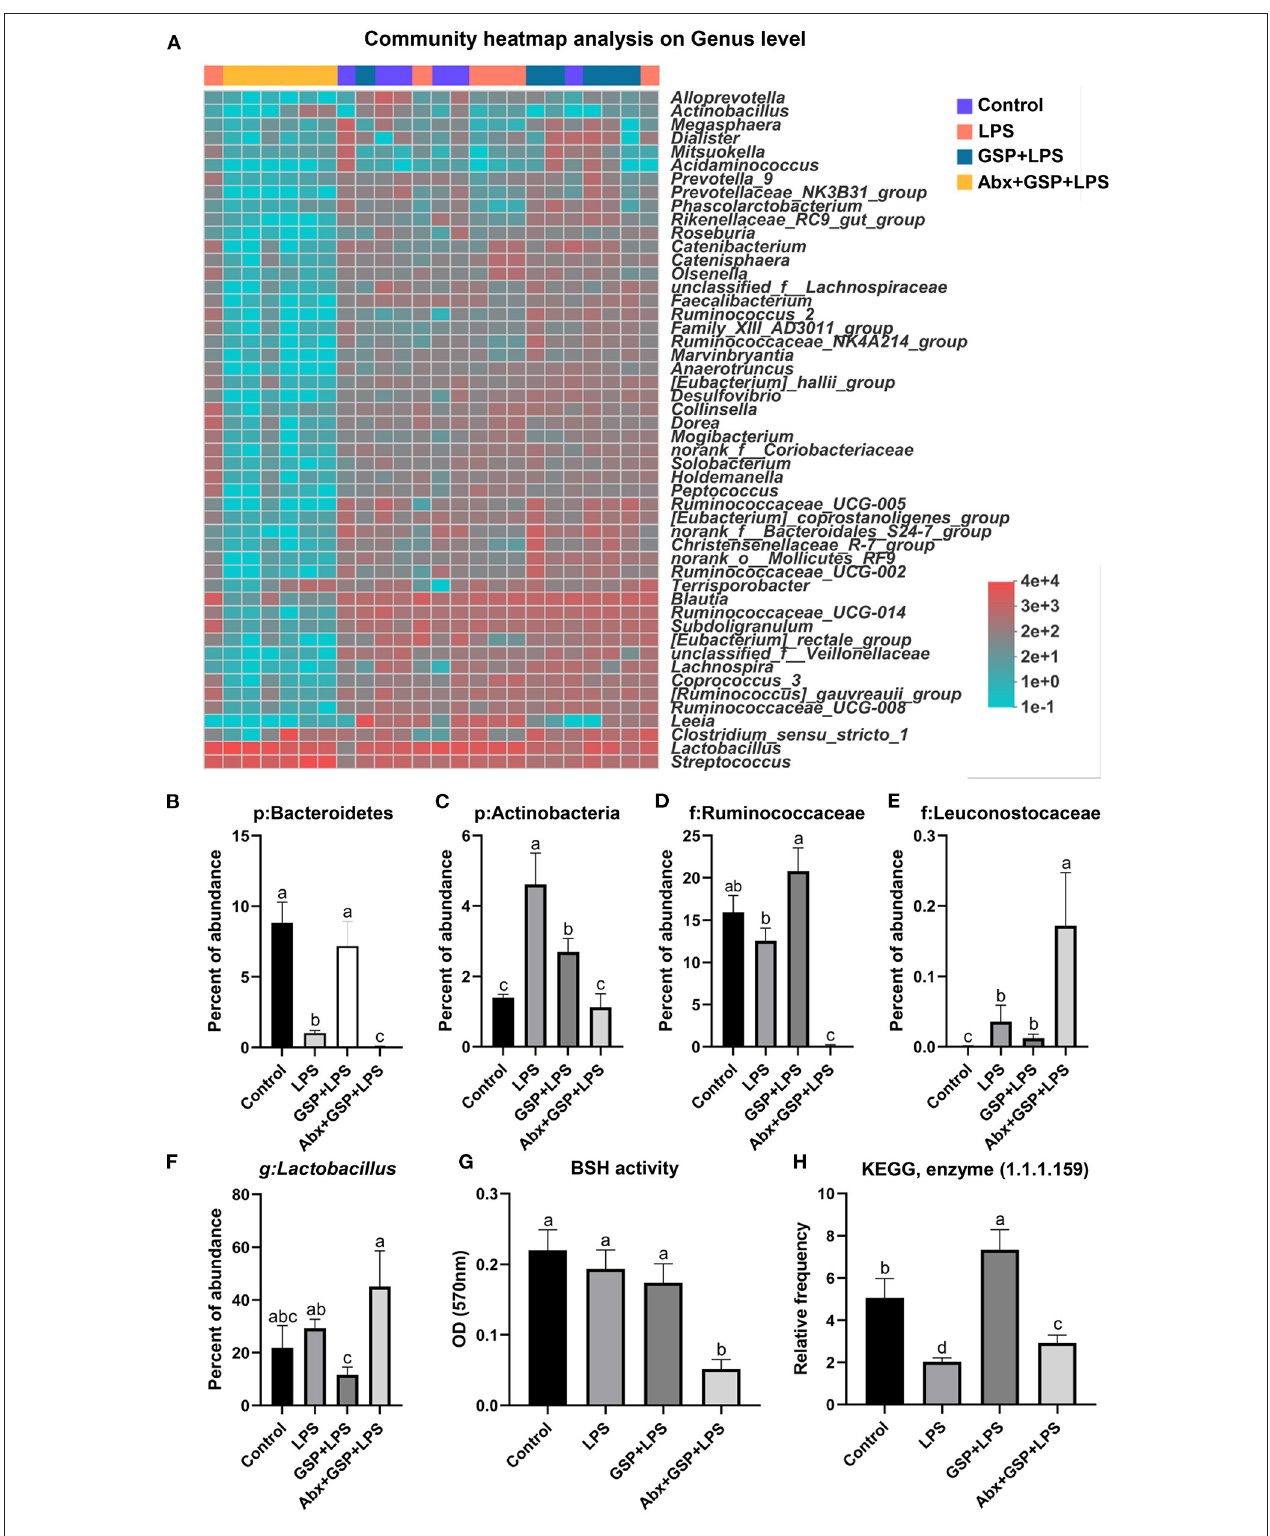
FIGURE 3 | The BSH activity and the abundance of BSH microbes in C57BL/6 mice with different treatments in Experiment 1. (A) The relative abundance of caecum bacteria at the genus level. (B–F) The relative abundance of Bacteroidetes, Actinobacteria, Ruminococcaceae, Leuconostocaceae, and Lactobacillus . (G) Fecal